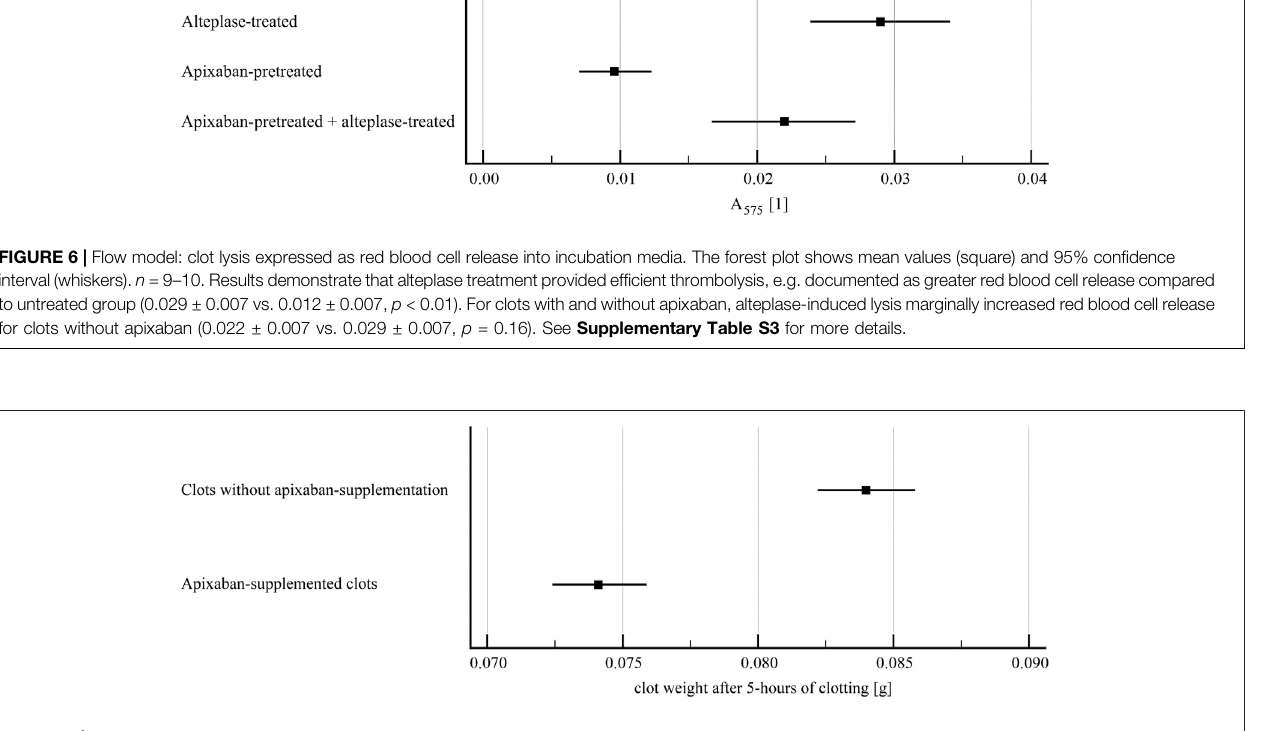
FIGURE 7 | Clot weight after 5-h of clotting. The forest plot shows mean values (square) and 95% con fi dence interval (whiskers). n (cid:1) 142 (clots without apixaban), n (cid:1) 137 (apixaban-supplemented clots). Results demonstrate that apixaban supplementation provided lower clot weight after 5-h of clotting compared to clots without apixaban (0.07 ± 0.01 g vs. 0.08 ± 0.01 g, p <